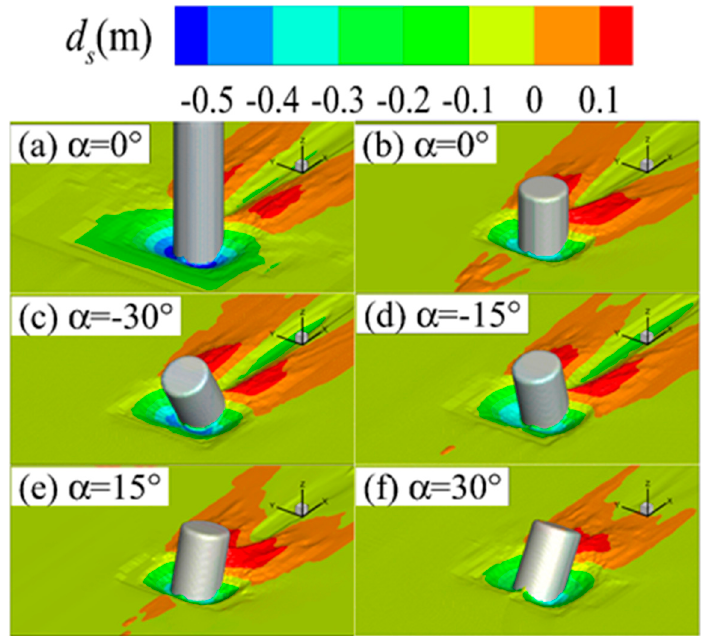
Figure 13. The distribution of the bed shear stress, ( a – f ) represents Case 1 to Case 6 in Table 2, respectively.